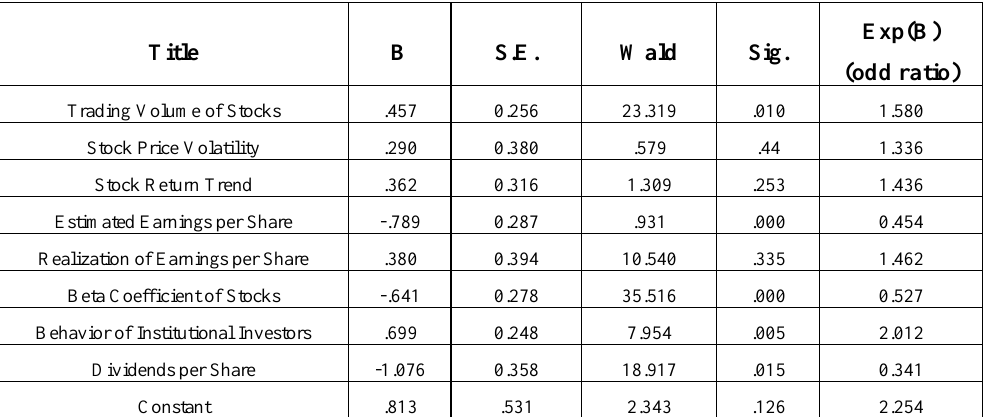
Table 3. Significant Determination of Coefficients of Independent Logistic Regression Variables